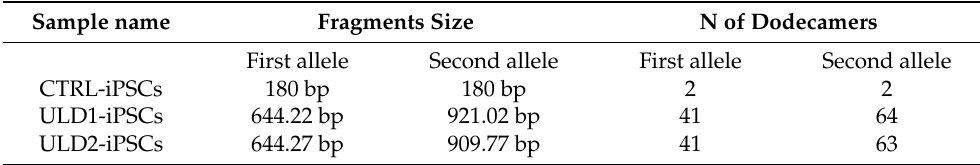
Figure 2. Quantification of the number of dodecamers by fragment length analysis. ( Left ) PCR amplification with 5 (cid:48) -FAM labelled primers of a portion of ~180 bp across the dodecamer repeats of the CSTB promoter, performed on genomic DNA extracted from CTRL and ULD iPSCs and visualization of the amplified fragments on agarose gel (100-bp DNA ladder was used as a size marker). The position of Fw and Rv primers (at − 296 bp and − 118 bp, respectively) is indicated. ( Right ) Fragment length analysis by capillary electrophoresis of PCR products. The sizes of the main fragments are indicated above the peaks in bp. At 180 bp is the peak for the CTRL (2 dodecamers); at 644 bp are the peaks for the first allele of ULD1 and ULD2 (41 dodecamers); at 921 bp is the peak for the second allele of ULD1 (64 dodecamers); at 909 bp is the peak for the second allele of ULD2 (63 dodecamers). GeneScan LIZ 1200 was used as marker size (orange peaks in CTRL electropherogram) and the data were analyzed by Eurofins with GeneMapper 6 software (Applied Biosystems). Representative images were created using Peak Scanner software (v. 2.0; Applied Biosystems). Table 2. Summary of data obtained with